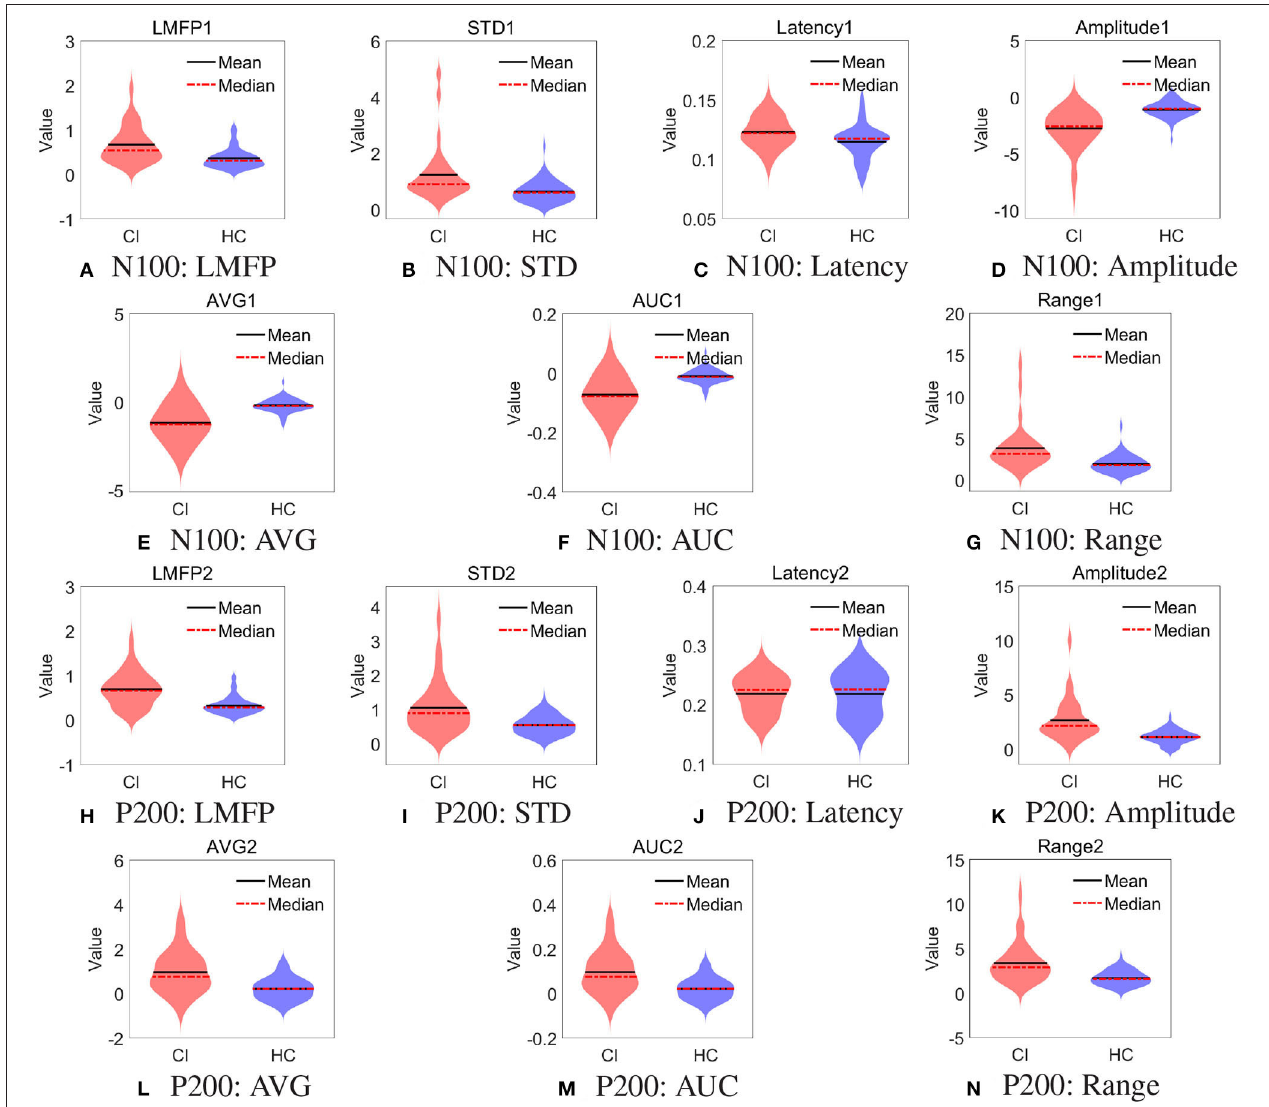
FIGURE 4 | Distribution of spatial features in right frontal region. (A) N100: LMFP, (B) N100: STD, (C) N100: Latency, (D) N100: Amplitude, (E) N100: AVG, (F) N100: AUC, (G) N100: Range, (H) P200: LMFP, (I) P200: STD, (J) P200: Latency, (K) P200: Amplitude, (L) P200: AVG, (M) P200: AUC, and (N) P200: Range.